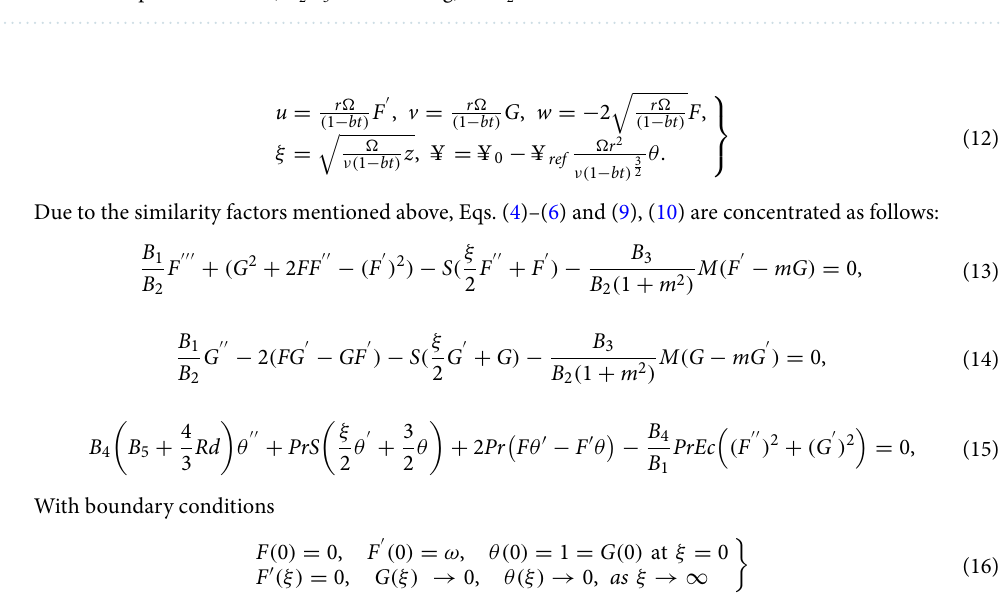
Table 1. Heat possessions of (Al 2 O 3 , CuO and Ag) in H 2 O.